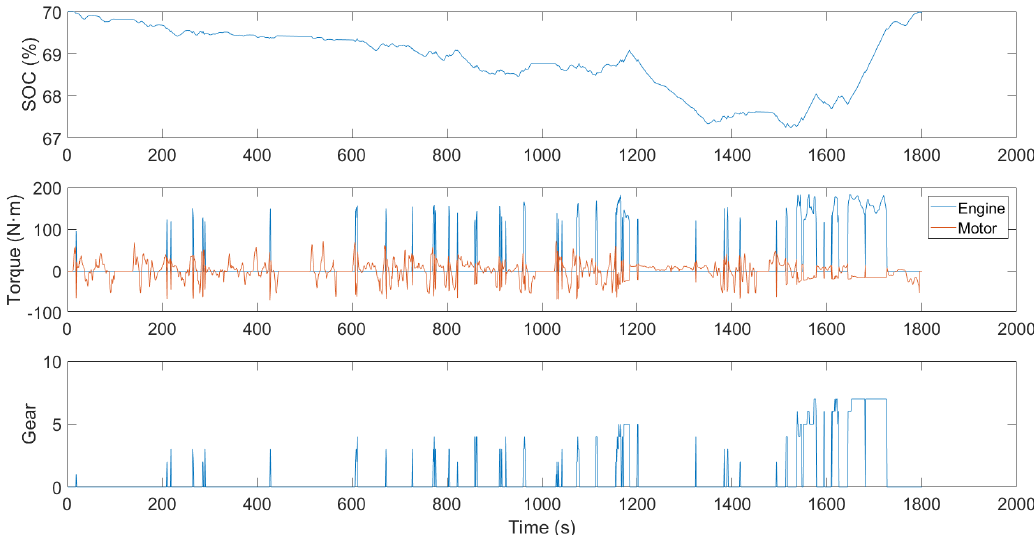
Figure 13. Three state parameters’ variation curves of µ max for emission